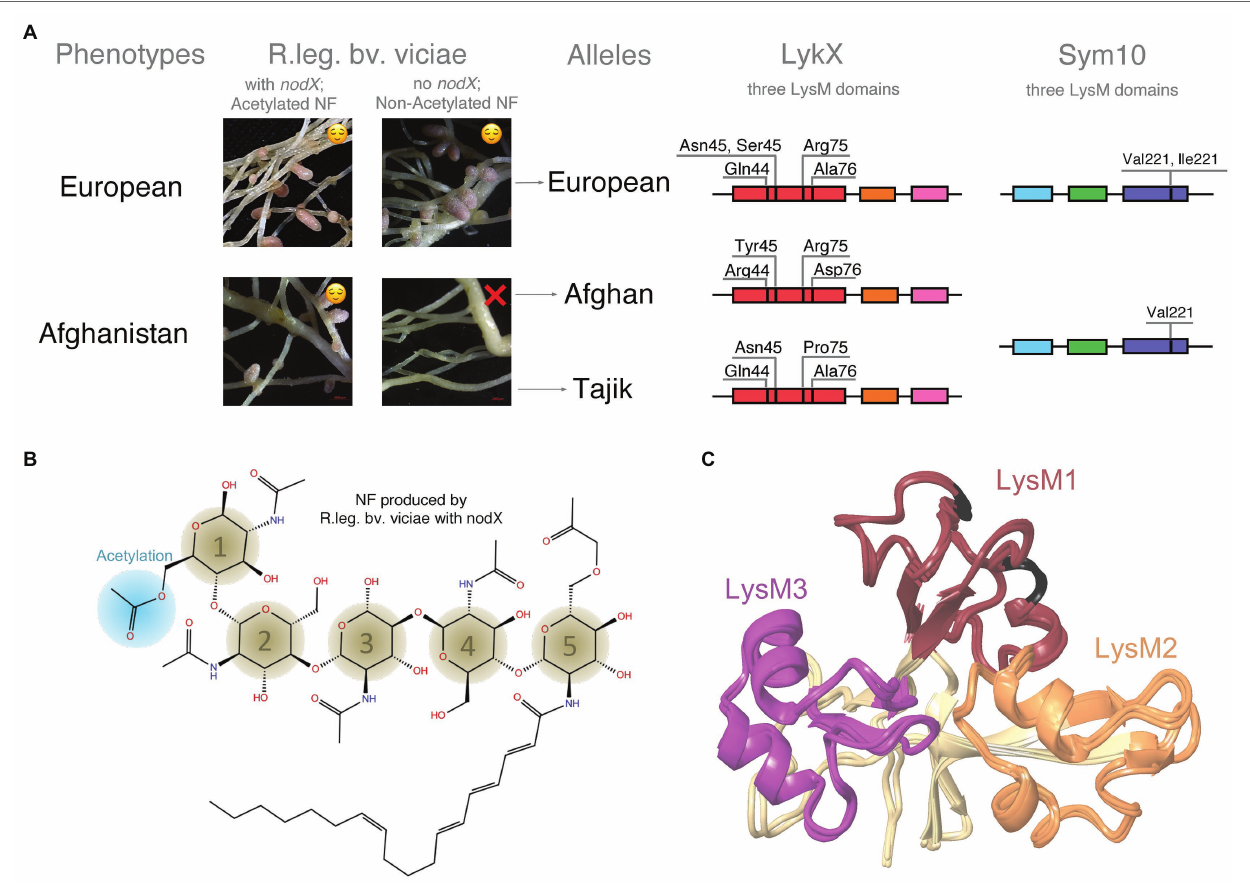
FIGURE 1 | (A) Phenotypes and alleles of garden pea ( Pisum sativum L.). Garden pea has two symbiotic phenotypes (European and Afghanistan) differing in symbiosis with R.leg.bv.vicia, which have no nodX gene and produce non-acetylated nodulation factors (NFs). At the molecular level, two alleles of LykX gene were found for Afghanistan phenotype (Afghan and Tajik). Three LysM domains and amino acid polymorphisms for LykX and Sym10 are shown. (B) Structure of a NF. (C) Structural alignment of the Afghan, Tajik, and European LykX proteins. LysM1 domains are colored in dark red (variable amino acids are highlighted with black), LysM2 – in faded orange, and LysM3 – in dark